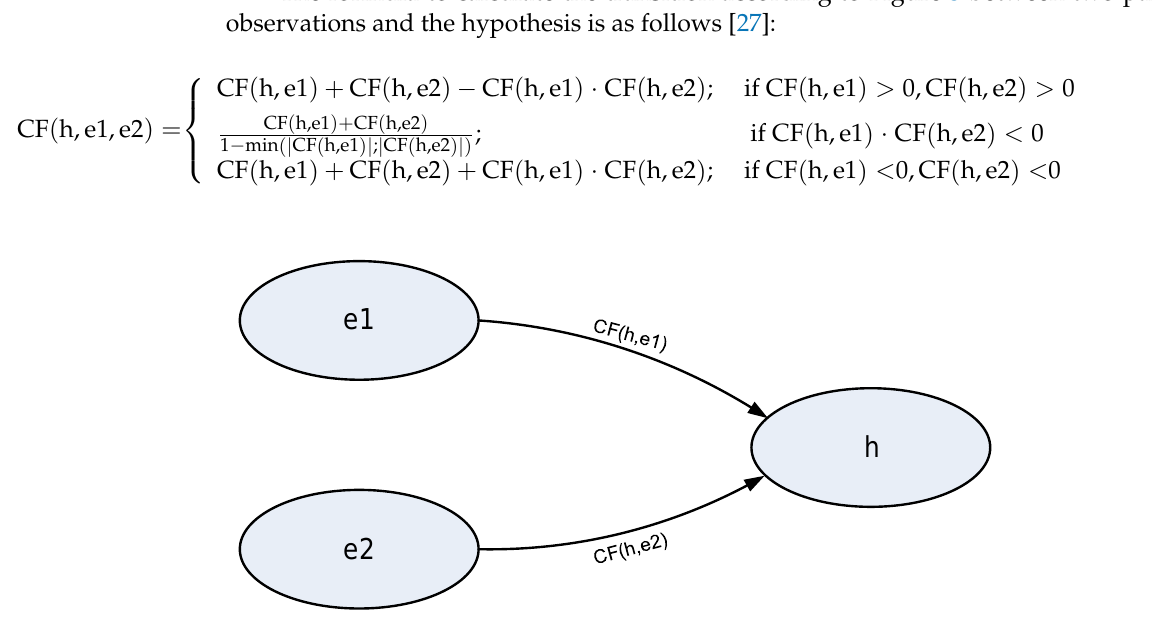
Figure 3. Parallel transitions between two observations and the hypothesis with marked CF values between nodes (the authors’ own study based on [2]).